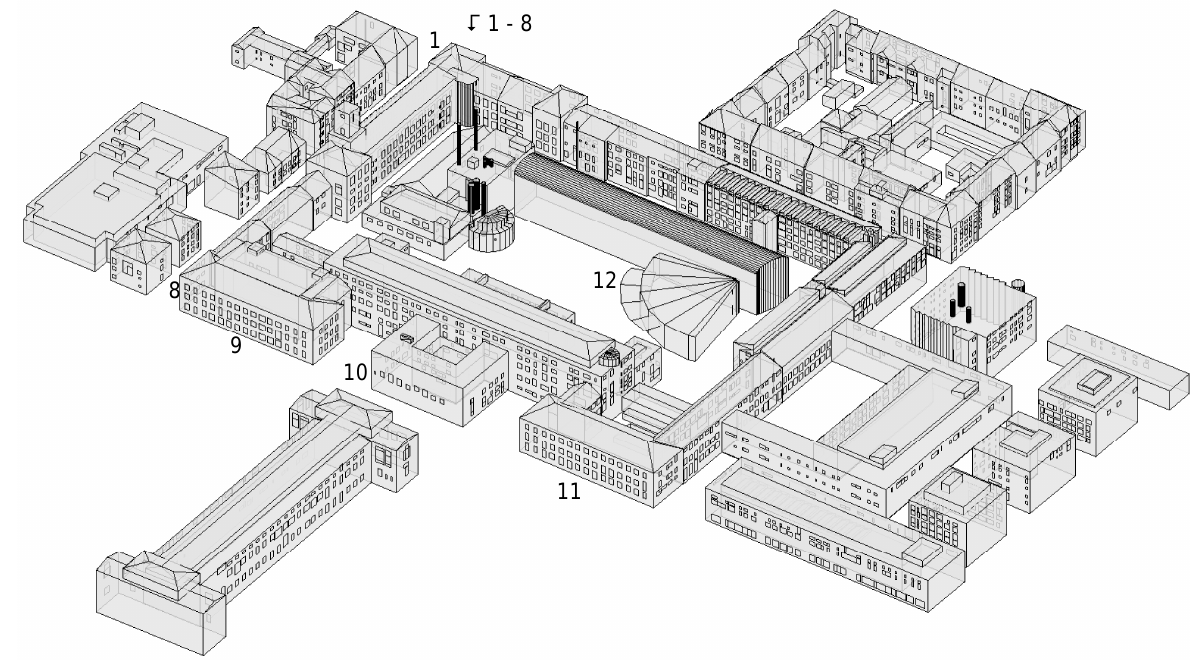
Figure 5. Final result, showing the model with reconstructed windows (I)